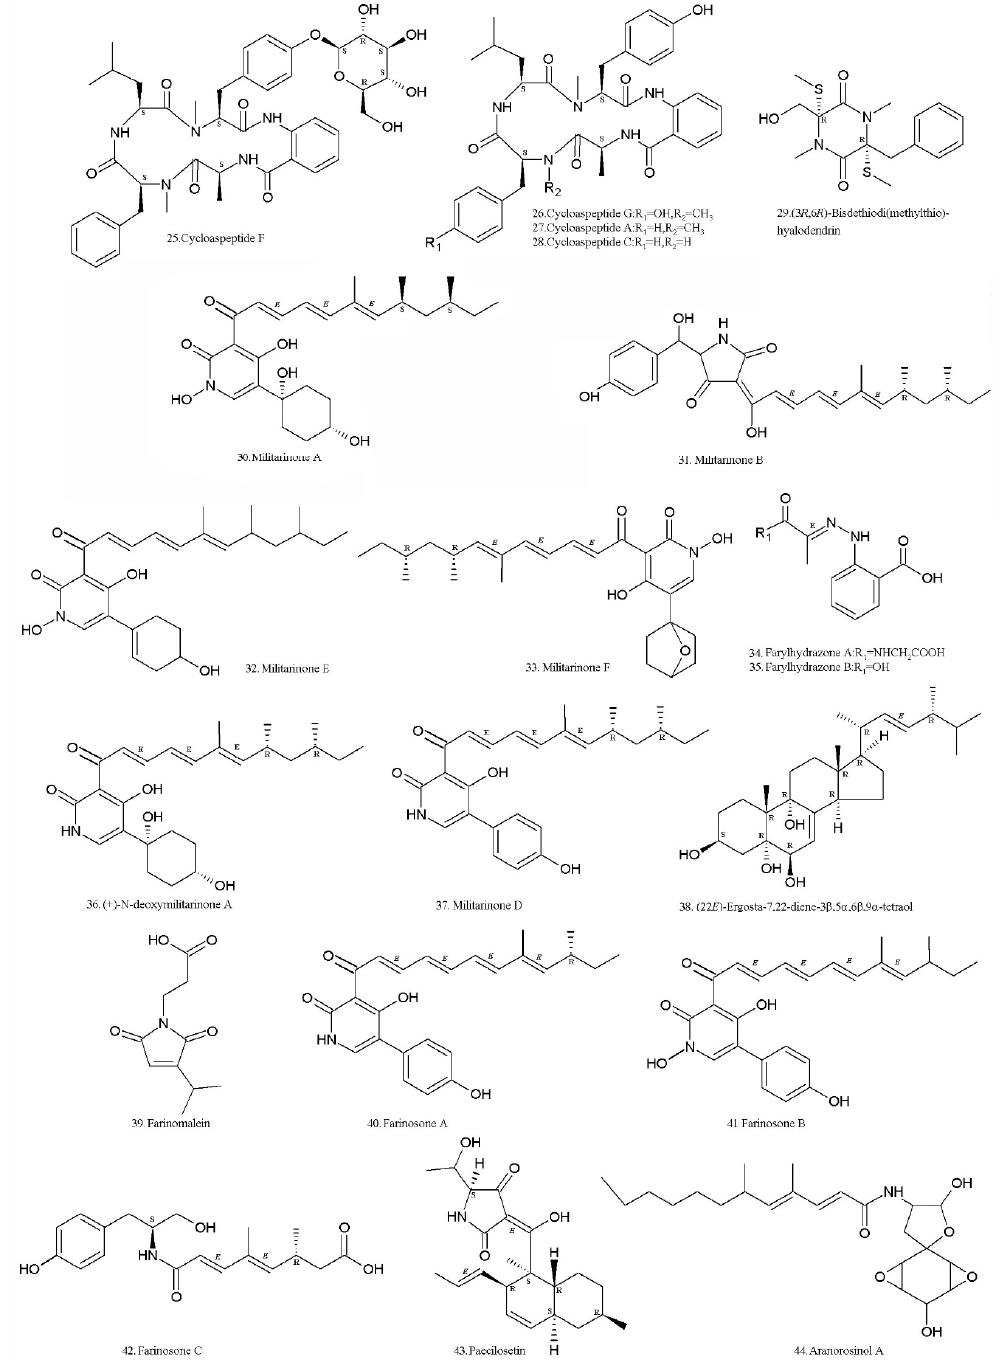
Figure 3. Structures of secondary metabolites (SMs) isolated from Isaria farinosa .